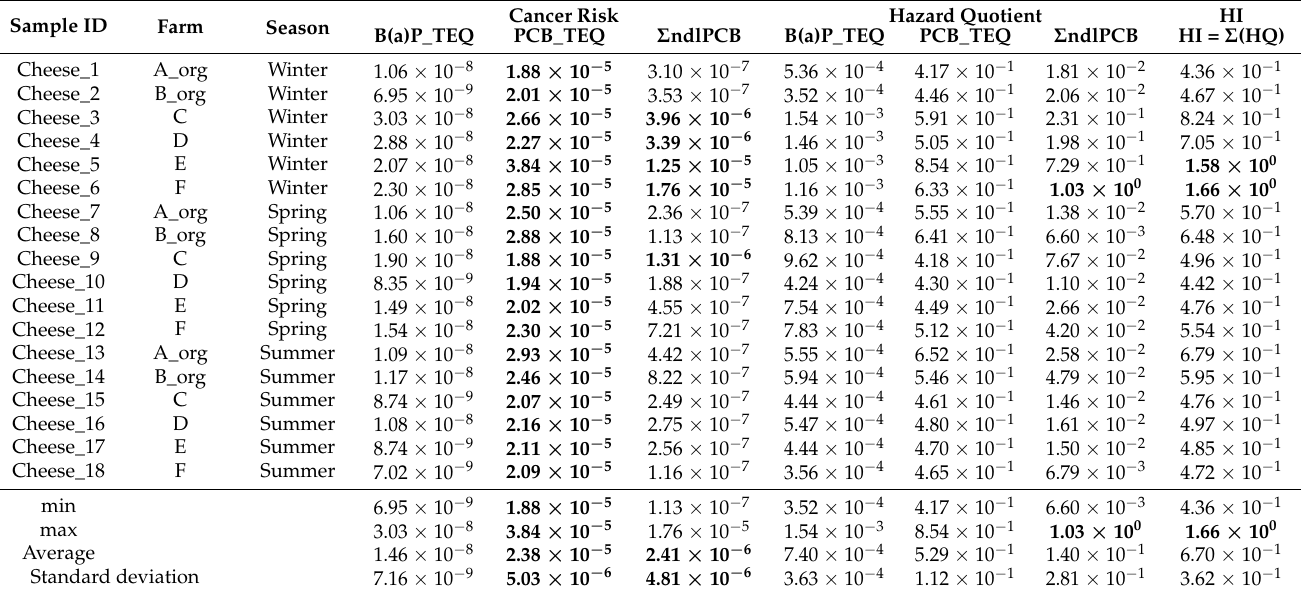
Table 6. Cancer risk, hazard quotient, and hazard index due to contaminated cheese ingestion. In bold values greater than 1 × 10 − 6 and